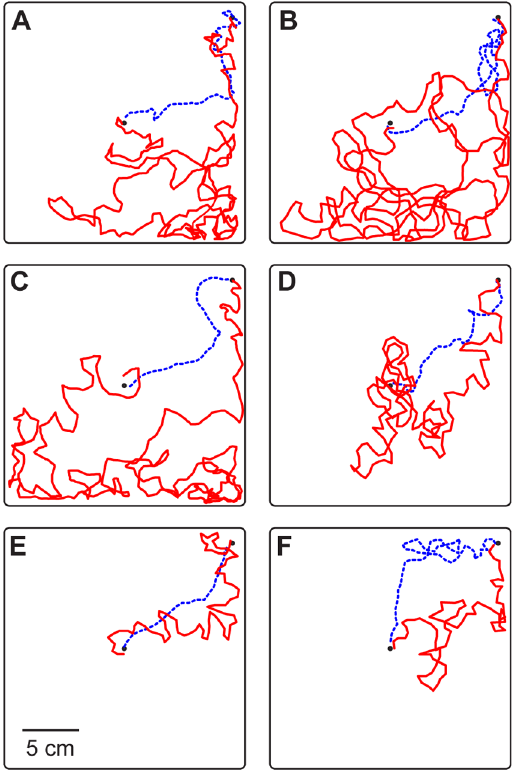
Figure 5. Sample paths before and after substrate rotation plus blocking of visual cues. Each panel shows a single ant’s paths before manipulation (dashed blue line) and afterwards (solid red line). Squares show arena boundary. Small closed circles show locations of old nest entrance at arena center and new nest entrance at upper right corner.